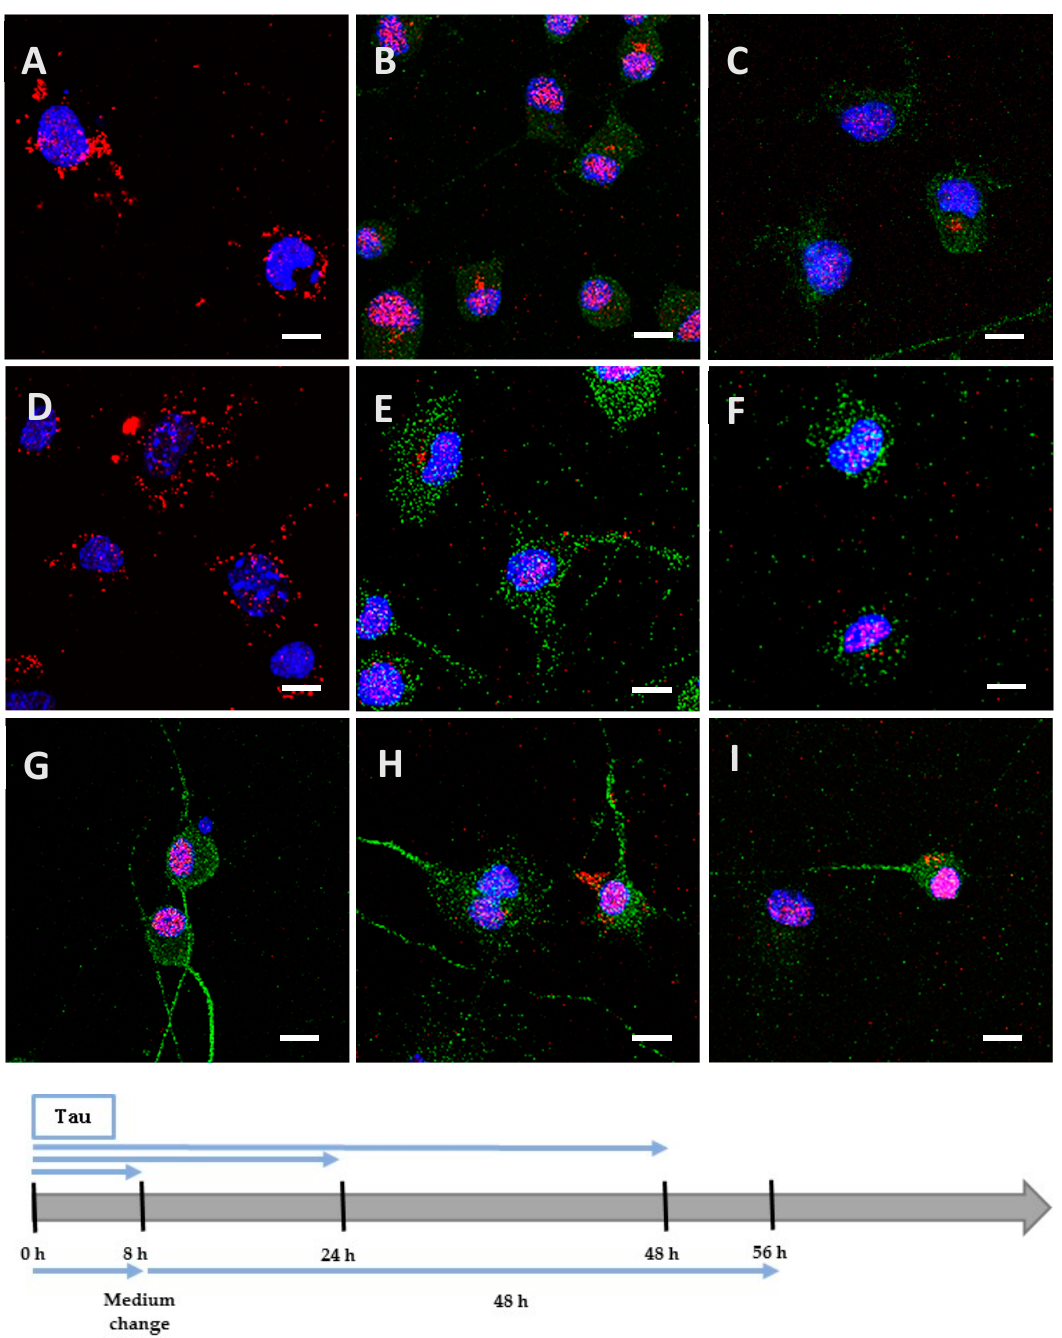
Figure 2. Internalization and processing of the Tau protein (15 µ g; A – C , H ) and its highly phosphorylated form (1.5 µ g; D – F , I ) by Neuro2A cells. Following 8 h ( A , D ), 24 h ( B , E ), or 48 h ( C , F ) of incubation with protein, cells were immunostained with a mouse anti ‐ His ‐ tag antibody targeted by an AlexaFluor ® 594 antibody (red) and a rabbit anti ‐ microtubule ‐ associated protein 2 (MAP2) antibody targeted by an AlexaFluor ® 488 antibody (green). In other experiments, cells were placed in contact with protein for 8 h, whereupon the medium was replaced by one devoid of protein and maintained for 48 h ( H , I ). The negative control ( G ) showed a non ‐ specific distribution of the anti ‐ His ‐ tag antibody, localized only in the nucleus. Nuclei were stained with 4 ′ ,6 ‐ diamidino ‐ 2 ‐ phenylindole (DAPI). All scale bars correspond to 10 μ m.